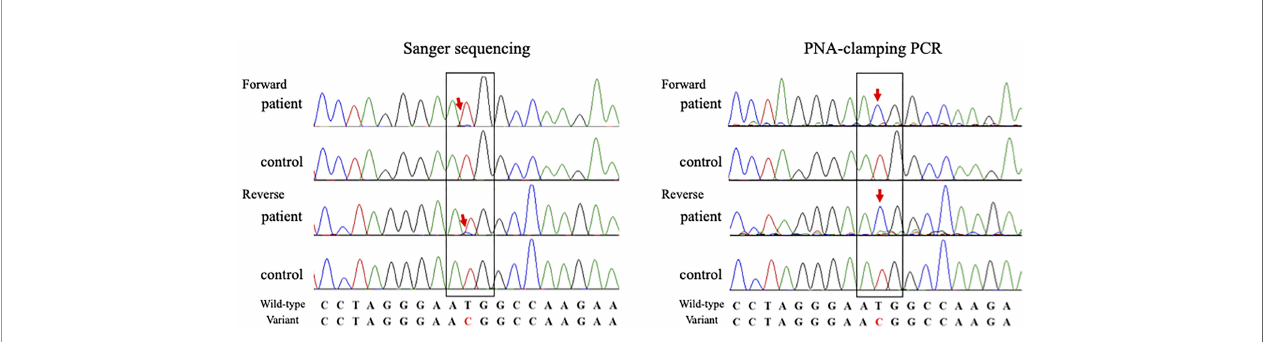
FIGURE 3 | Sanger sequencing (exome sequencing) of genomic DNA from peripheral blood (red arrows) revealed that the patient had the electropherogram ’ s peak of a somatic variant in UBA1 (NM_003334.3:c.122T>C:p.Met41Thr). To further validate the low-prevalence somatic variants in UBA1 , peptide nucleic acid-clamping polymerase chain reaction was performed. The pathogenic variant at c.122T>C:p.Met41Thr is seen (red arrows) in a condition where the wild-type allele was not ampli fi ed.